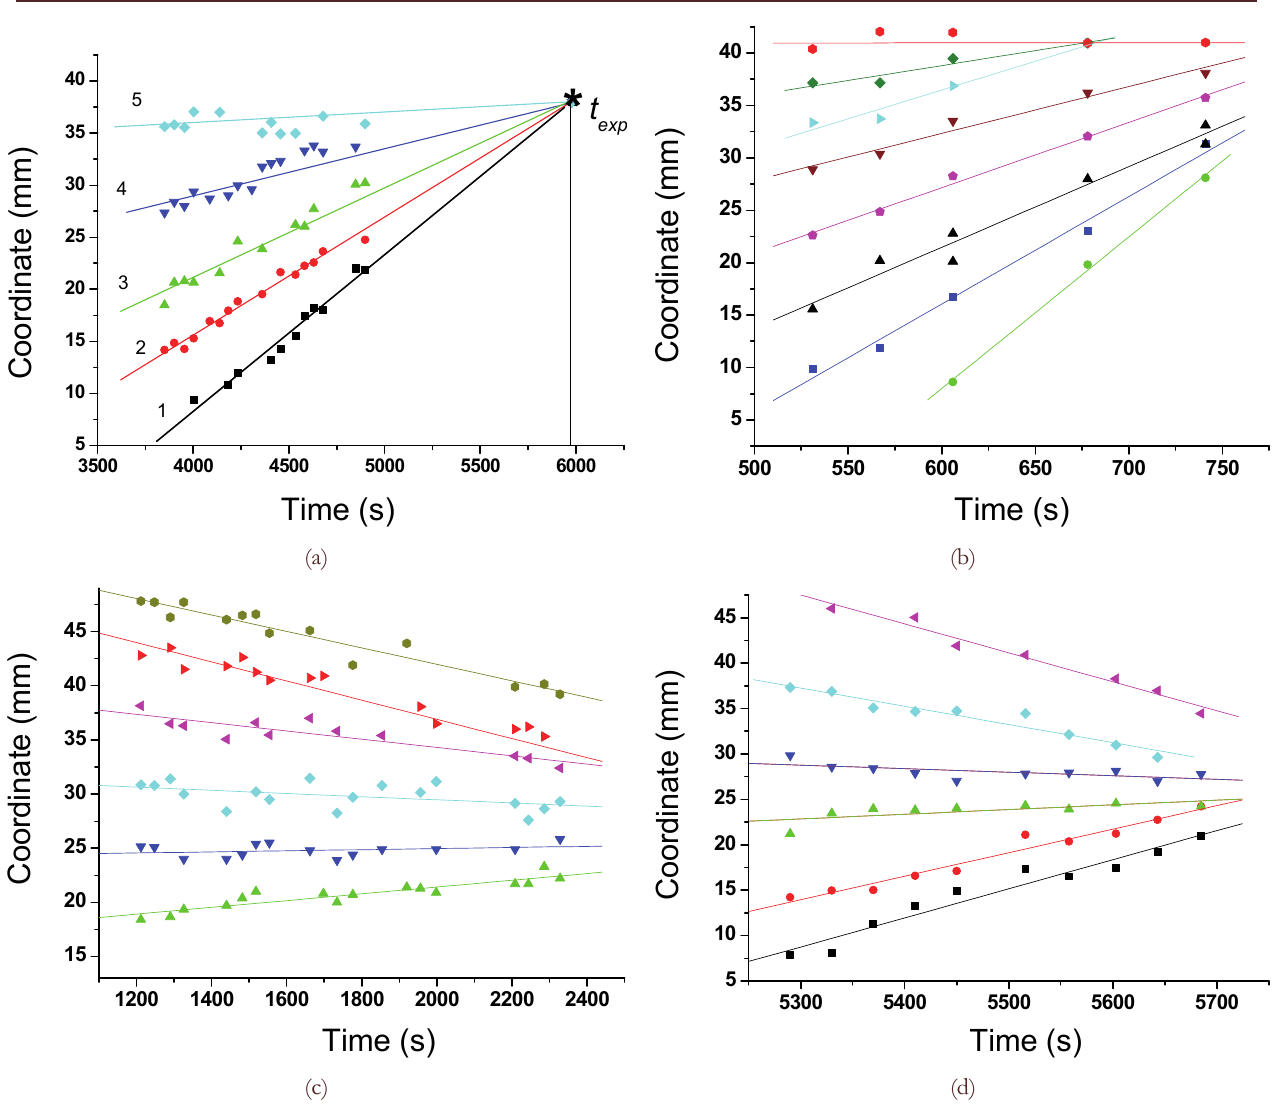
Figure 4: Movement of localized plasticity domains at the stage n <0.5: a - for steel (G10080); b - for steel (AISI 420); c - for silicon iron; d - for steel (321H).